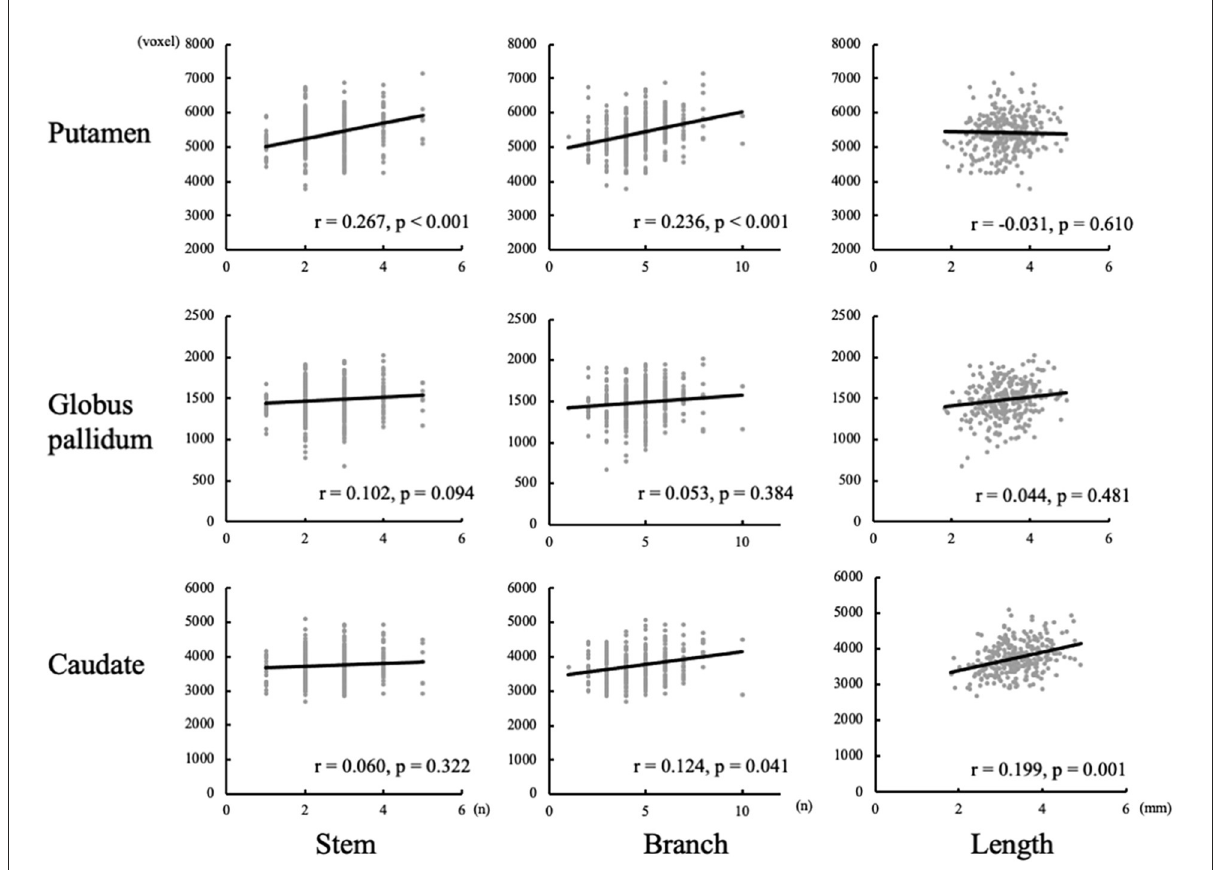
FIGURE3 Correlation between basal ganglia volumes and measurements of lenticulostriate arteries